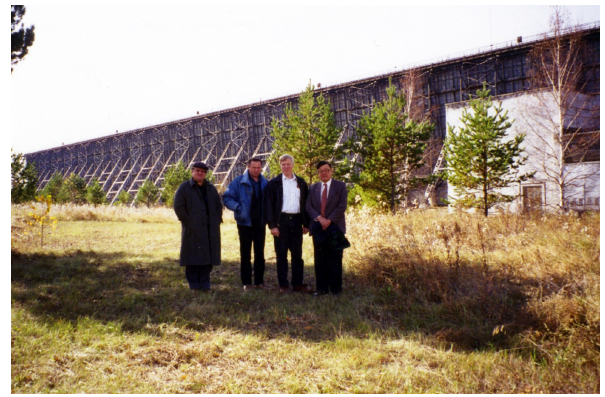
Figure 4. Near the radar antenna. Left to right: Vasily Mikhailovsky, Alexander Potekhin, John Foster, and Gely Zherebtsov.